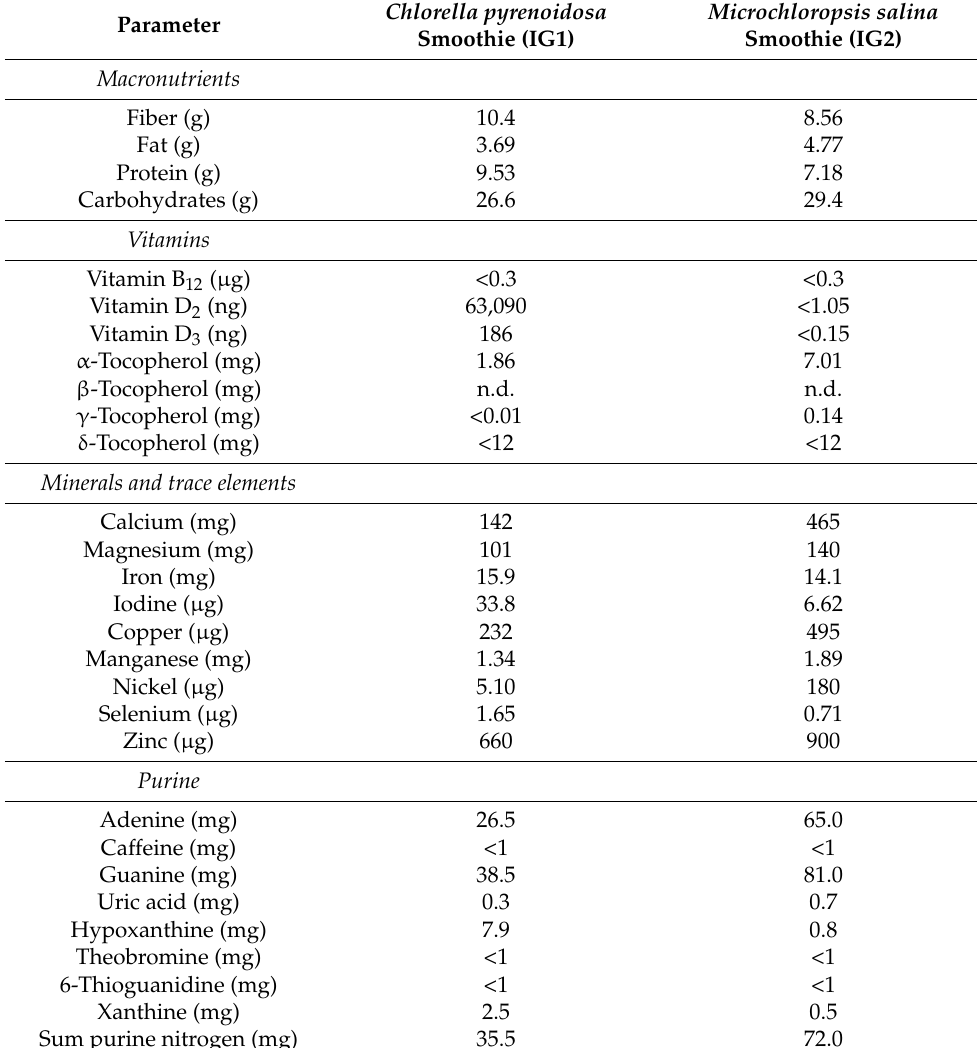
Table 1. Nutrient profile of both intervention products in total (350 mL smoothie per